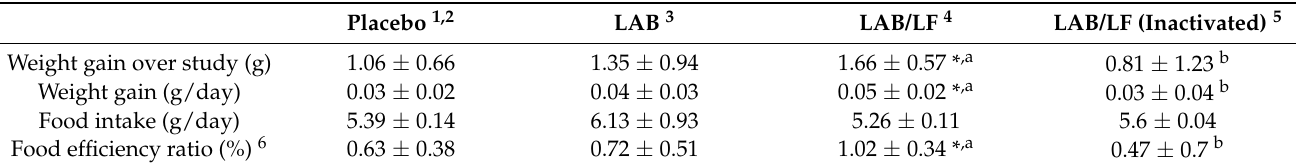
Table 1. Body weight, food intake, food efficiency ratio, and tissue weight in four groups of diet- induced obese (DIO) mice supplemented with a placebo or one of three probiotic mixtures for four weeks. The results are presented as means ±